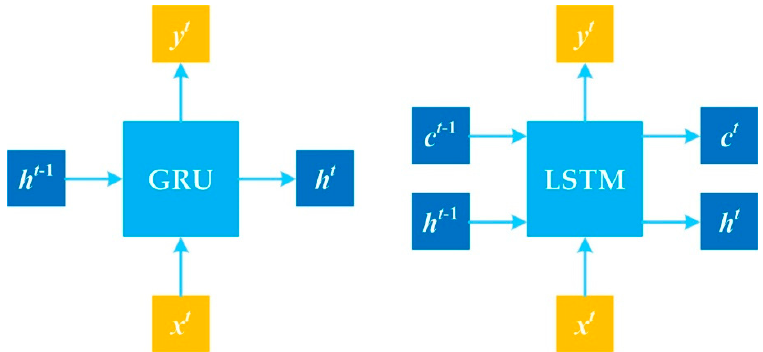
Figure 4. Structural comparison between GRU and LSTM .